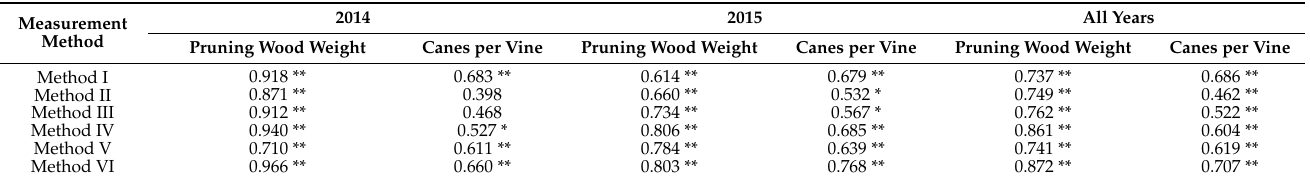
Table 6. Pearson’s correlation of the laser scanner measurements with the measured pruning wood parameters of Syrah